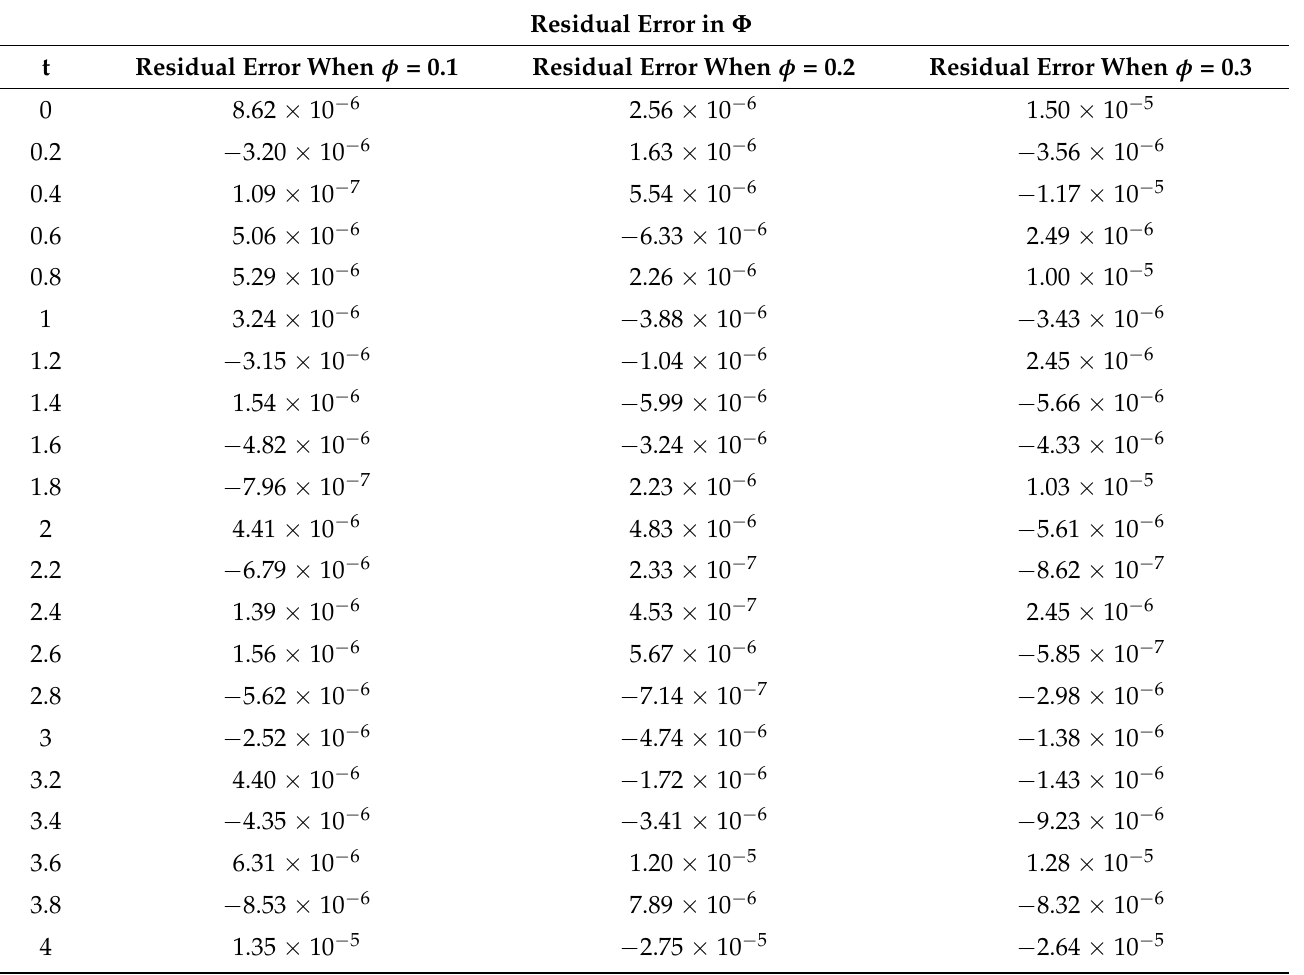
Table 18. The residual error in Φ are shown in the following the